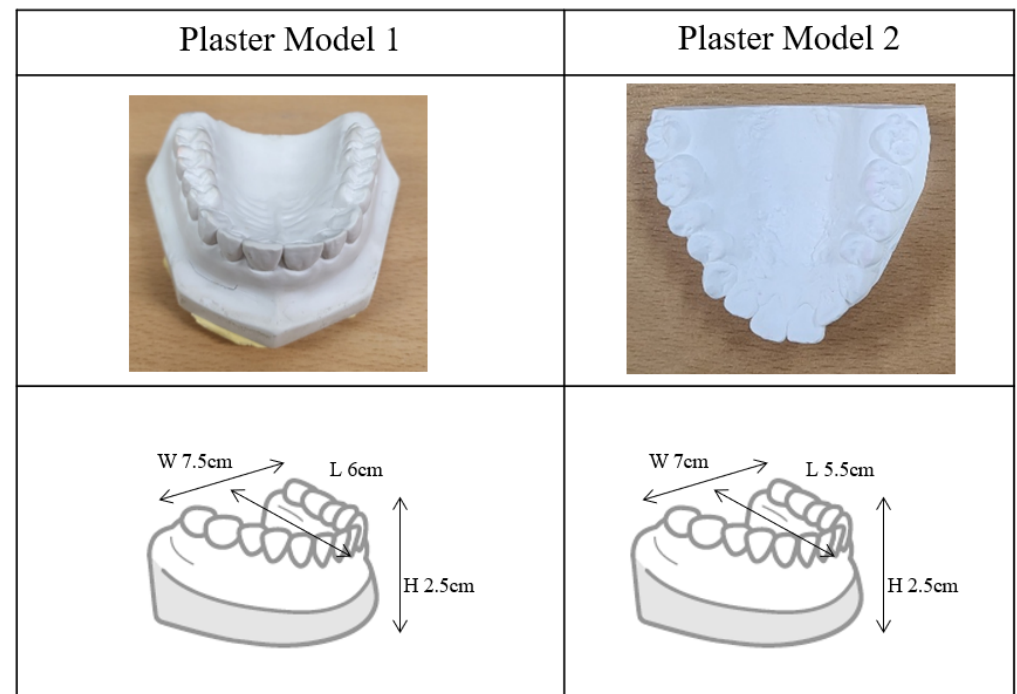
Figure 2. The photographs and dimensions of the plaster models used for the micro-CT scan.